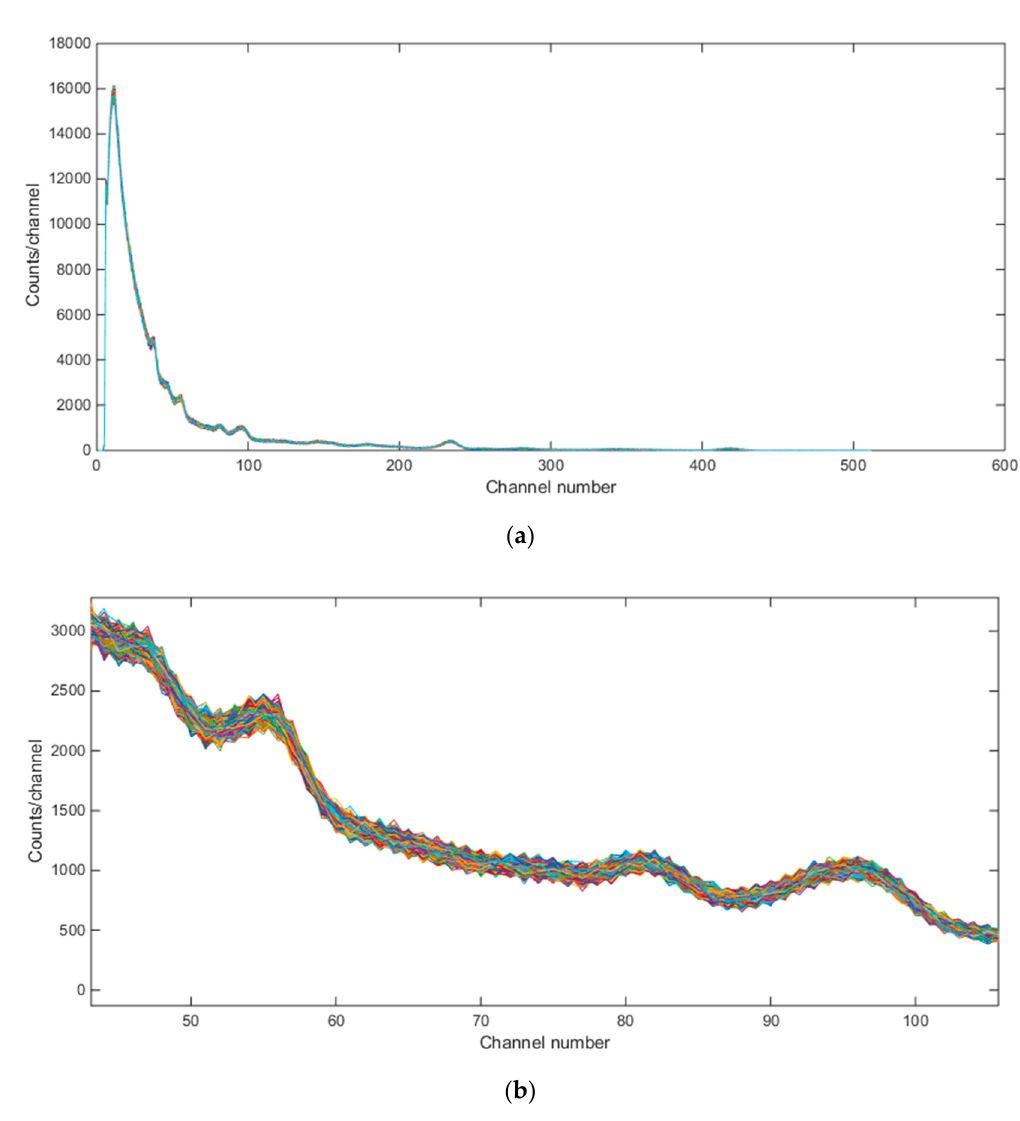
Figure 6. Emulated background gamma ray spectra (for Baltimore, MD) for 4,290 separate simulations. ( a ) whole spectrum; ( b ) zoomed version.